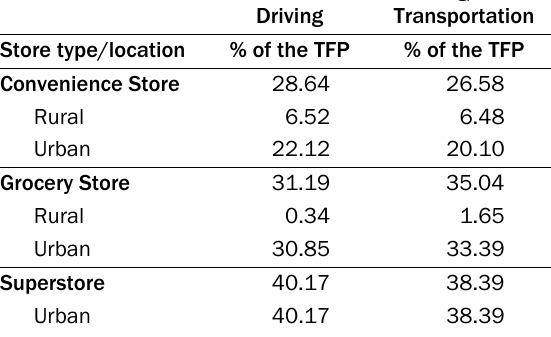
Table 2. Percentage of items purchased by residents using driving and walking/public transportation according to store category and location.